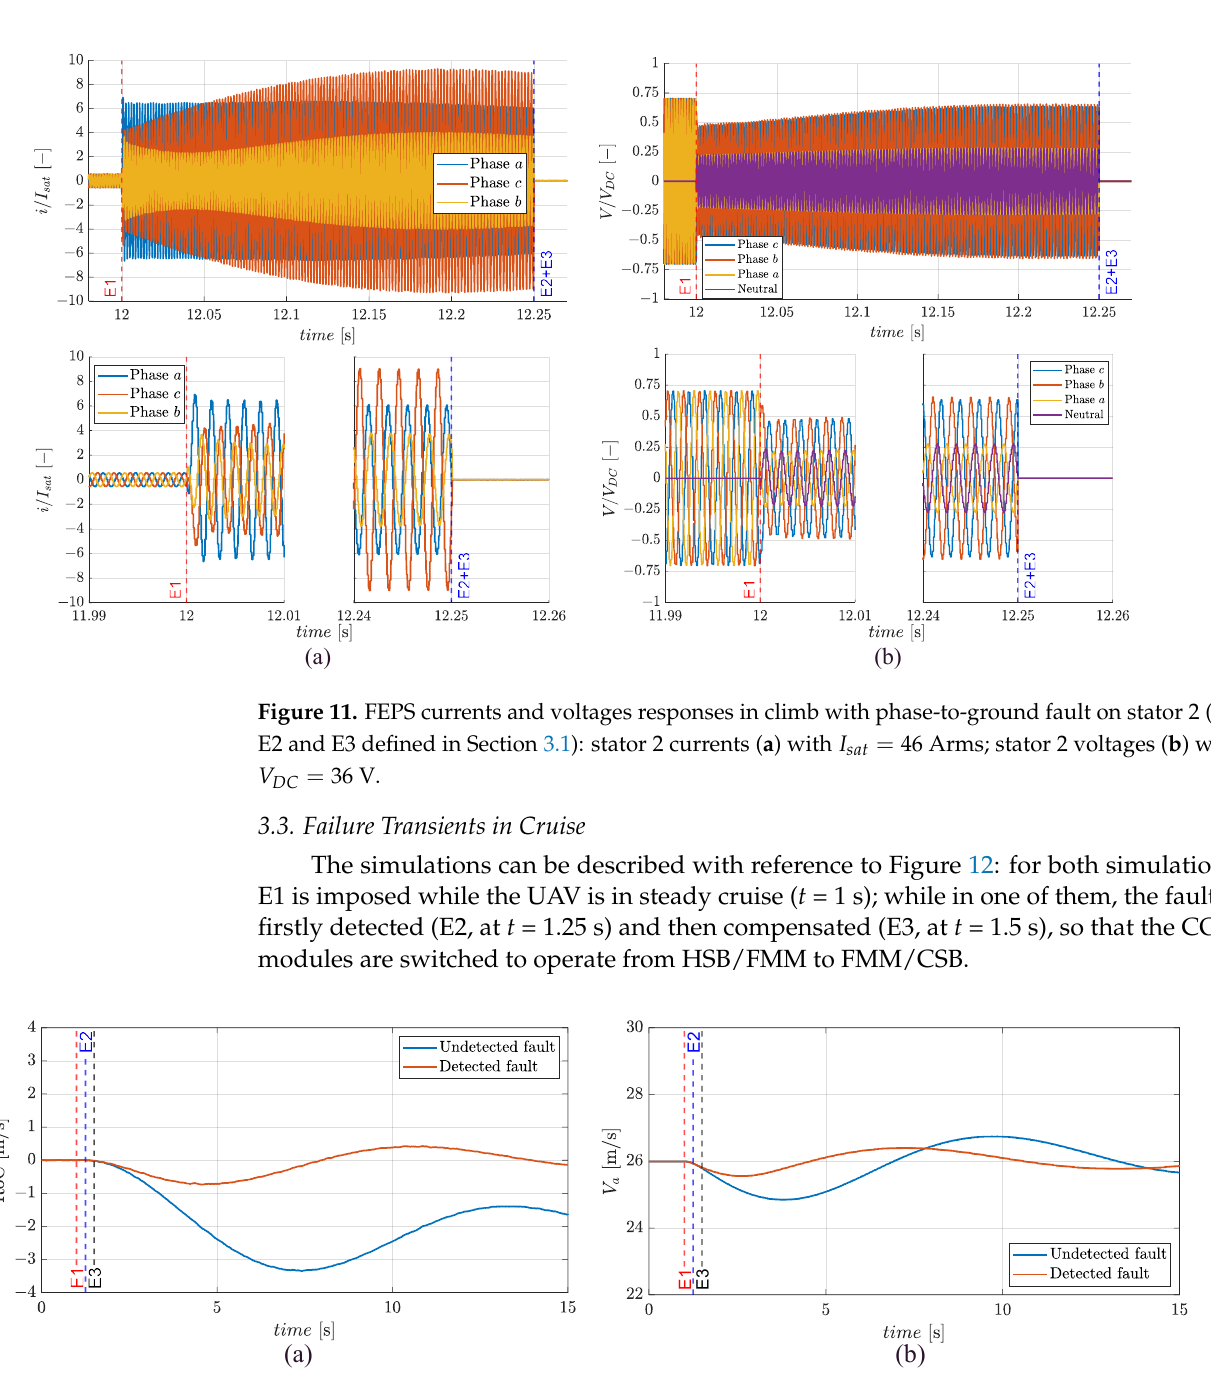
Figure 12. UAV response in cruise with phase-to-ground fault on stator 2 (E1, E2 and E3 defined in Section 3.1): RoC ( a ), airspeed ( b ).